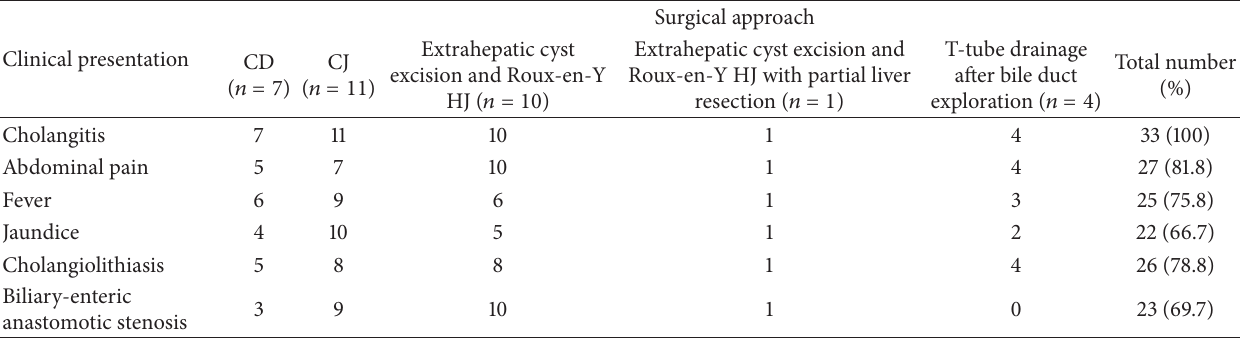
Table 1: Surgical approaches and postoperative clinical presentations of 33 patients treated at other hospitals who developed postoperative malignancy.